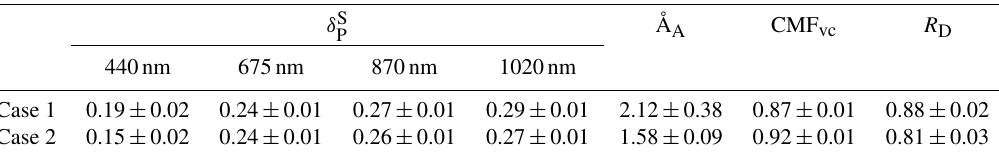
Table 5. Parameters for cases 1 and 2 for group 6 at Osaka, linear particle depolarization ratio ( δ S from the sun–sky radiometer data, absorption-related Ångström exponent (Å A ), coarse-mode fraction on the basis of the volume concentra- tion (CMF vc ), and dust ratio ( R D ) at 1020nm.